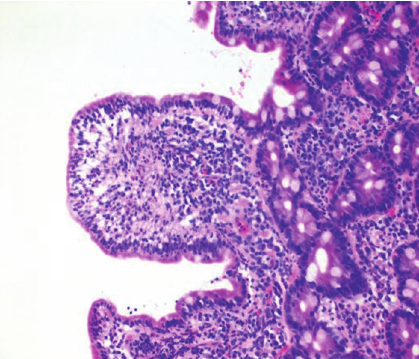
Figure 4: H&E high power view of jejunal biopsy showed increase in lamina propria cellularity with eosinophilic infiltration.